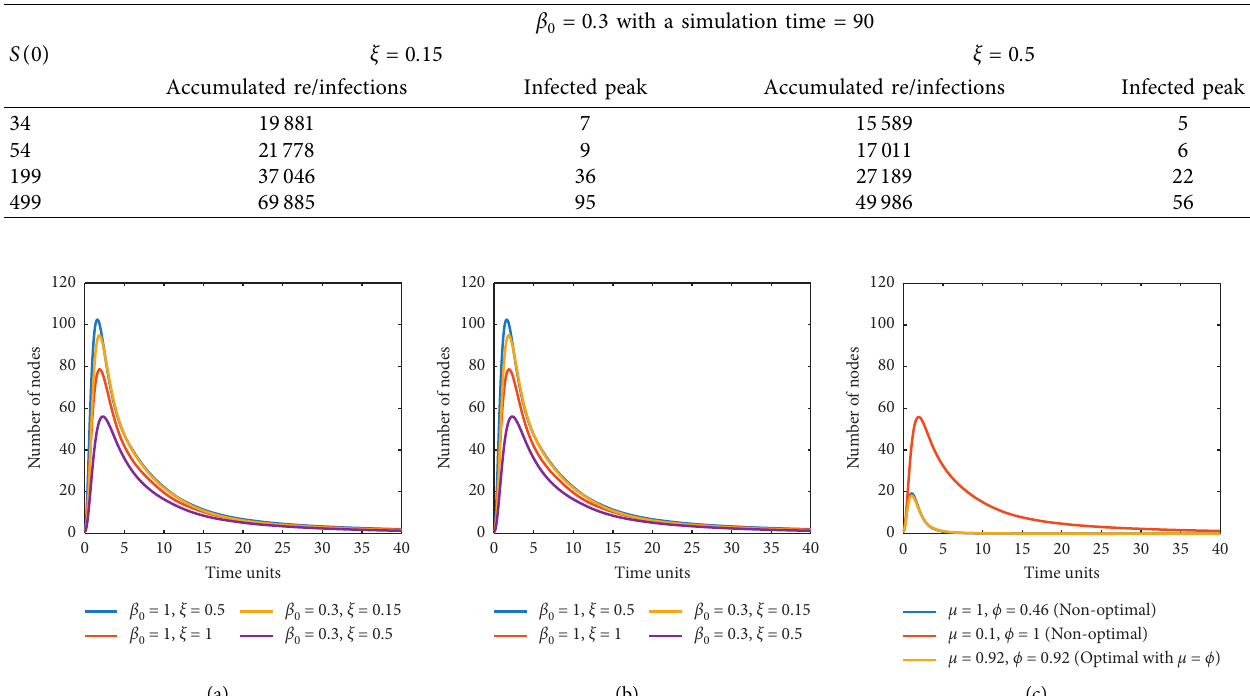
and ξ . (b) Infected 0